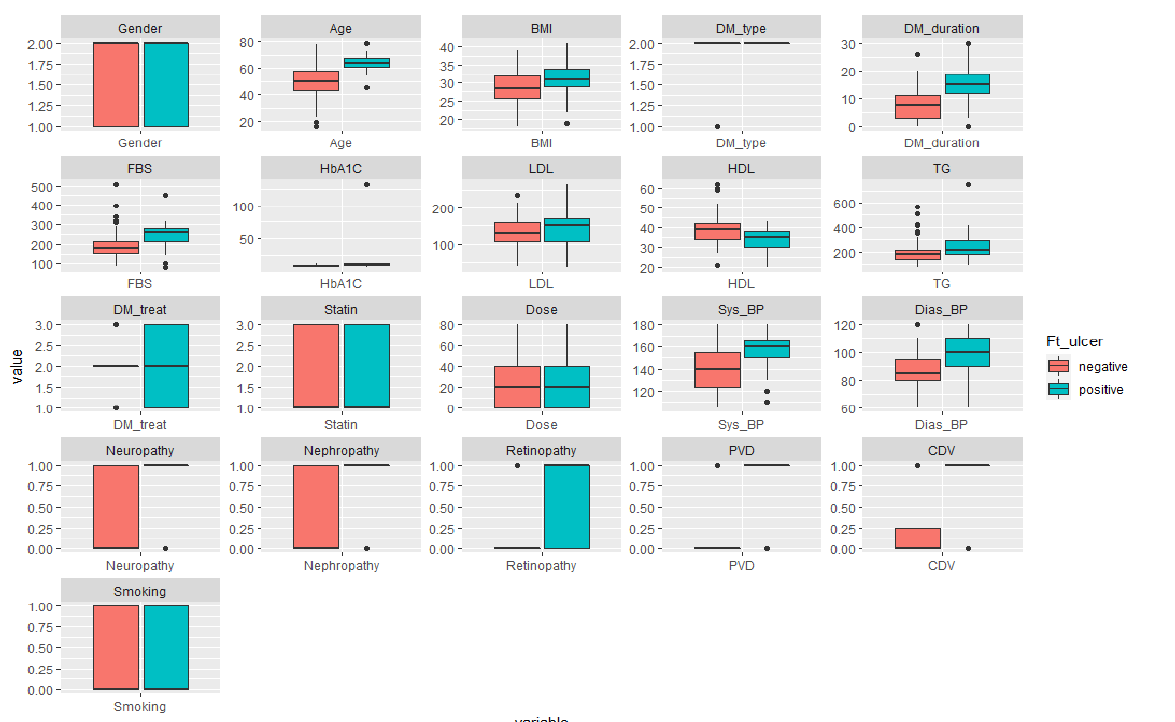
Figure 2. Box plot for the dataset attributes